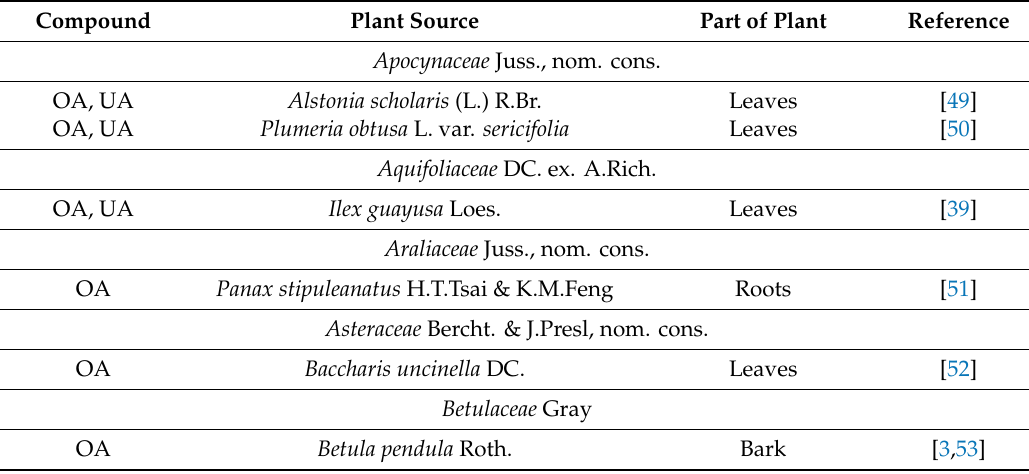
Table 1. Some plant sources of oleanolic acid (OA), ursolic acid (UA), and glycyrrhetinic acid (GA). Compound Plant Source Part of Plant Reference Compound Apocynaceae Juss., nom. cons. OA, UA Alstonia scholaris (L.) R.Br.